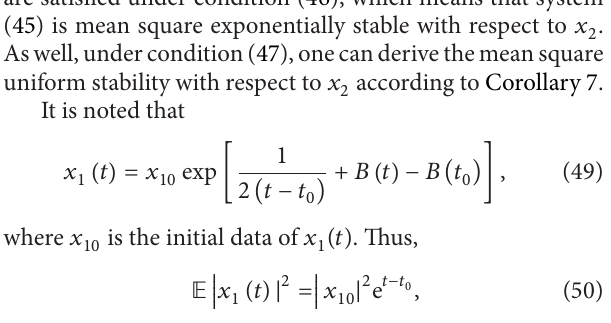
Figure 3: The solution to system (51) with impulses (single